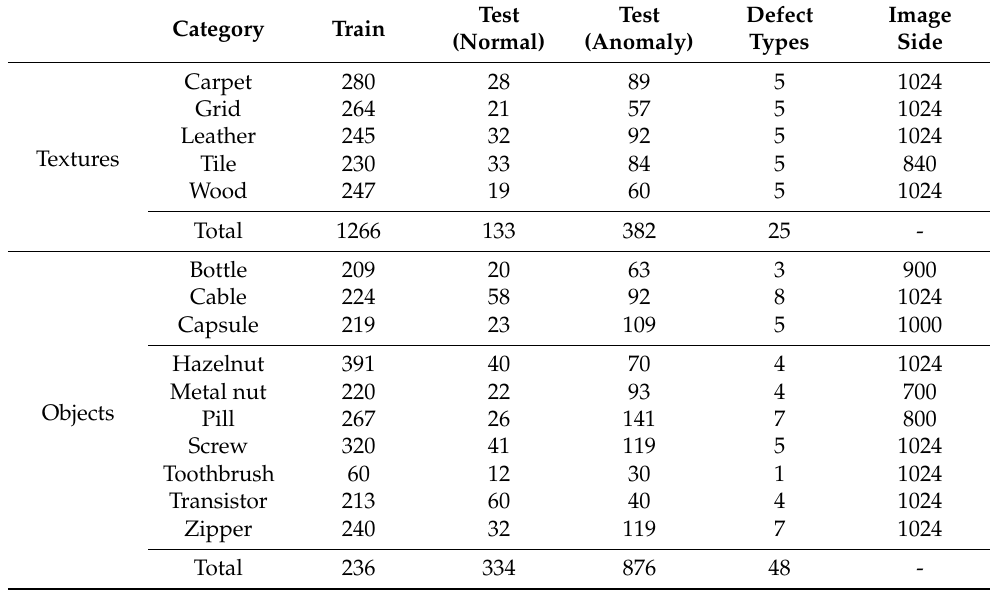
Figure 5. Normal samples and samples with surface defects in the MVTec dataset. The area in the red box contains the surface defect of each product. Table 1. Detailed information of the MVTec.